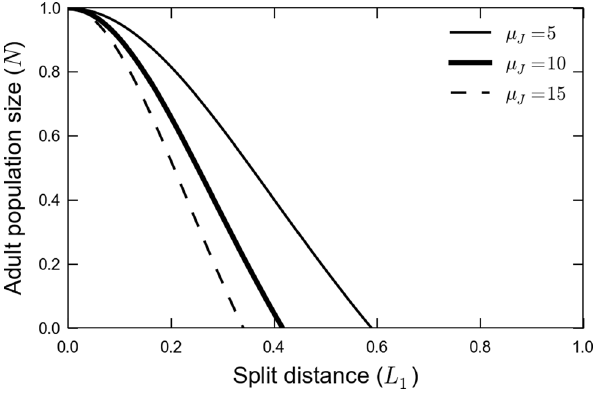
Figure 3. Population size of adults in the fragment as a function of the split distance, L 1 This picture points a critical split above which the population gets extinct. The three curves distance L (cid:2) 1 indicated in the figure represent different values of the juvenile mortality m J that can be caused by differences in matrix quality. The parameters used were r ~ K ~ D J ~ D A ~ 1 , b ~ 0 and m A ~ 0 : 01 .